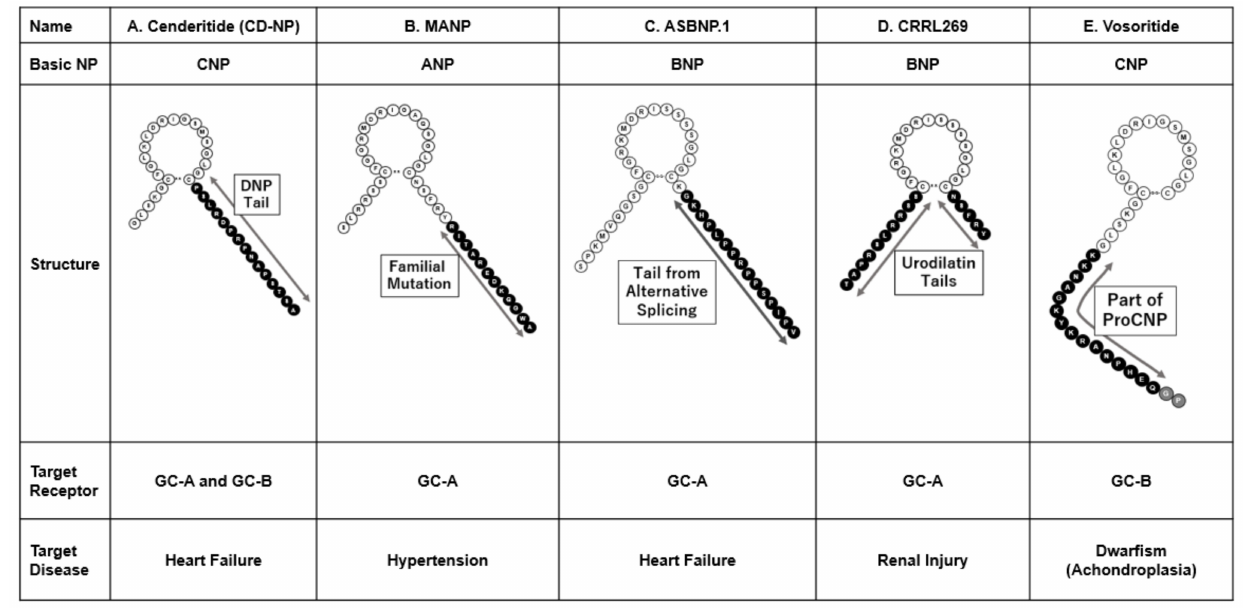
Figure 2. Designer NPs: Modified or combination of NPs. DNP, Dendroaspis natriuretic peptide; GC-A, guanylyl cyclase-A; GC-B, guanylyl